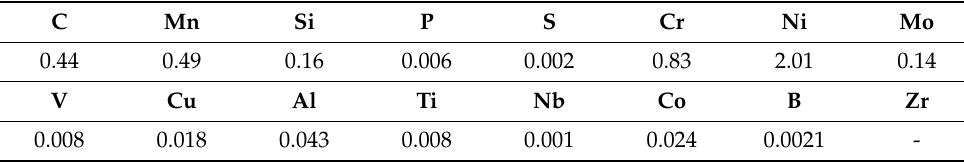
Table 1. Contents of chemical elements in Hardox Extreme steel